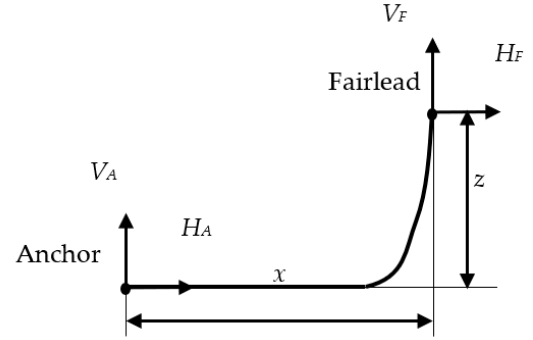
mooring. Due to the complexity of the shallow water mooring, eight mooring lines are applied to keep the coupled structure in position, which features two sets of upwind lines and two sets of downwind lines. The mooring line adopts a gearless catenary type, and it is Grade 4. Table 4 lists the detailed parameters of the mooring